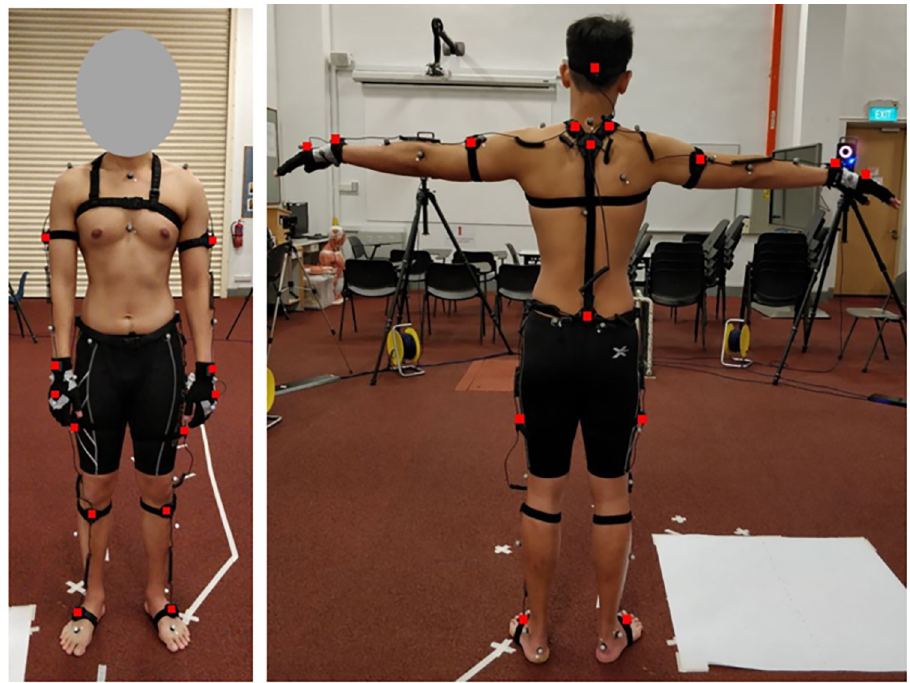
Fig 2. Participant set-up with both PNS and VICON markers front and back. The red squares indicates the PNS sensor positions. https://doi.org/10.1371/journal.pone.0262730.g002 Participants were required to perform a series of tasks. Description of these can be found in Table 2. Participants performed 10 repetitions for each task. During the performance of the tasks, care was taken to ensure that participants’ movement were not obstructed in any way as a result of the reflective markers and the PNS. Compression garments (2XU Compression Shorts, Melbourne, Australia) were used during the data collection to minimize the marker movements whilst still allowing participants to be covered. Compression garments were cho- sen as it had been previously reported that markers placed over compression garments demon- strate low variance in movement compared to the markers placed on the skin [29]. Table 2. Description of tasks to be performed.